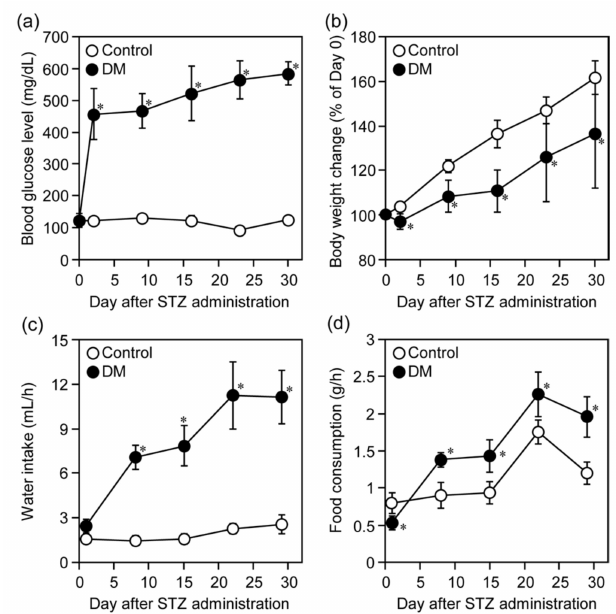
Figure 3. STZ administration induced DM conditions in rats. Blood glucose levels ( a ), body weight ( b ), water intake ( c ), and food consumption ( d ) in rats were measured just before (day 0) and weekly for 3 weeks after i.p. administration of STZ (50 mg / kg) to them. Each point represents the mean ± SD for 10 (control) and 6 (STZ) rats. * p < 0.001 (vs.